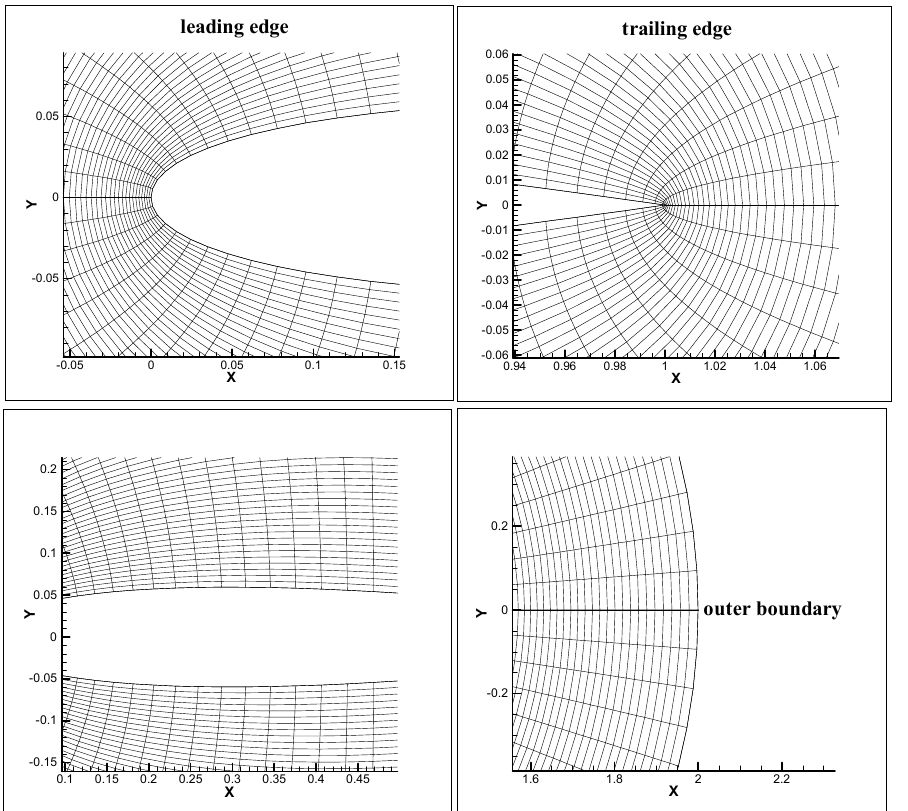
Figure 3. Magnified view of different parts of domain.